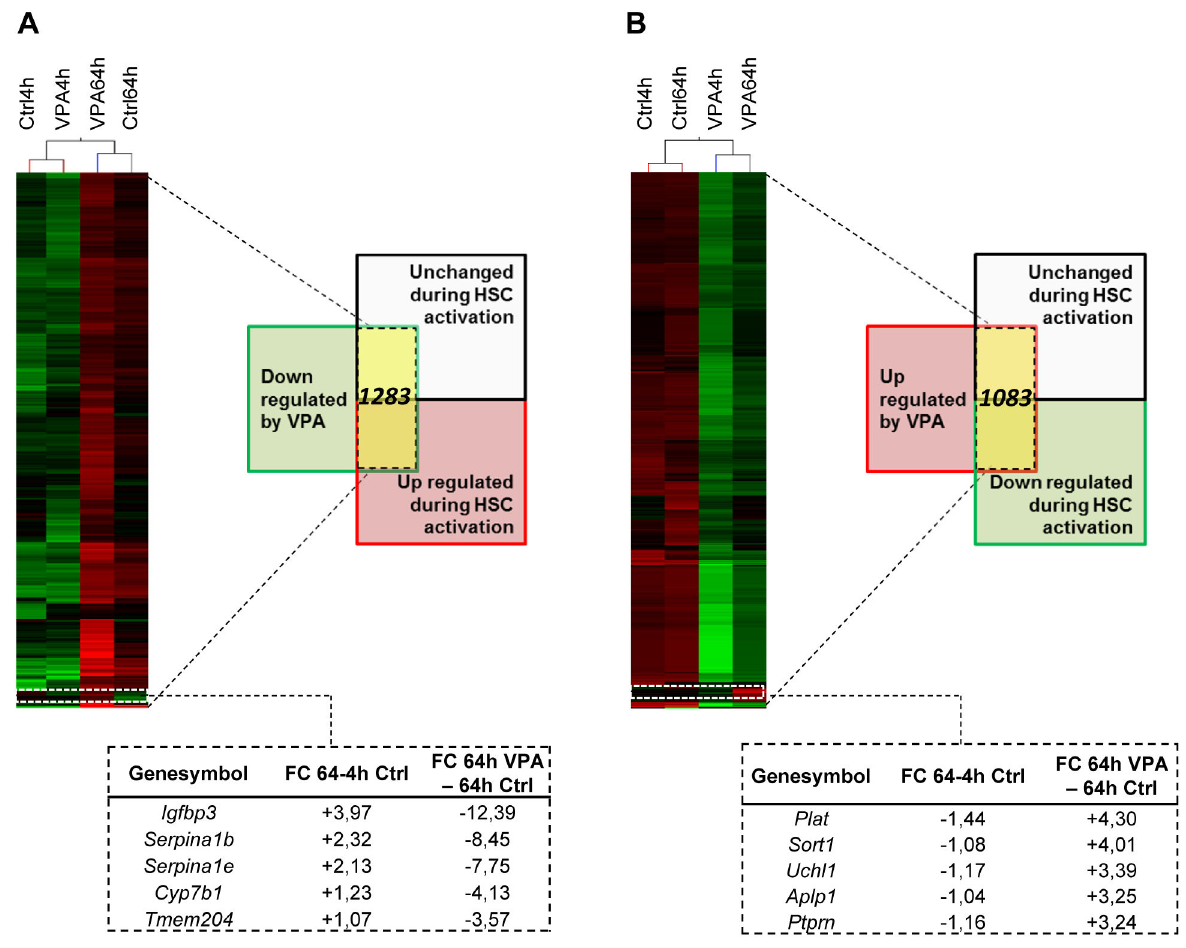
Figure 3. Gene expression changes by VPA treatment. ( A ) Hierarchical clustering analysis on genes with statistical significance (one-way anova, P < 0.05 followed by Benjamini-Hochberg correction), with at least a 2-fold down regulation by valproic acid (VPA) treatment (Ctrl64h vs. VPA64h) and with an up regulated/unchanged expression during hepatic stellate cell (HSC) activation. ( B ) Hierarchical clustering analysis on genes with statistically significance (one-way anova, P < 0.05 followed by Benjamini-Hochberg correction), with at least a 2-fold up regulation by VPA treatment (Ctrl64h vs. VPA64h) and with a down regulated/unchanged expression during HSC activation. Gene selection used for clustering analysis is highlighted in yellow in both schemes and the 5 top genes from this group are extracted from the clustering tables. Green color indicates a low expression value, black color indicates an intermediate expression value and red color indicates a high expression